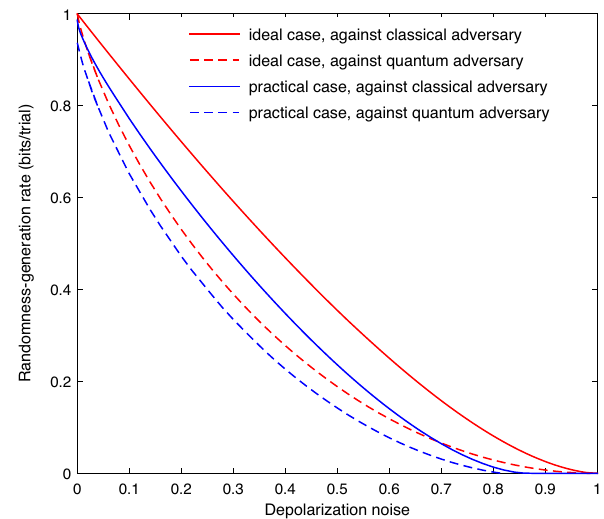
Fig. 1 Asymptotic randomness-generation rates R c and R q as functions of the depolarization noise d . For illustration purpose, here we simulate the result at a trial according to either the X -basis or Z -basis measurement on the depolarized single-photon state ð 1 (cid:2) d = 2 Þ 0 j i 0 h j þ d = 2 1 j i 1 h j , where 0 j i and 1 j i are the two eigenstates (in the single-photon subspace) of the Z - basis measurement and d quanti fi es the depolarization noise. At each trial the X -basis measurement is selected with probability P X = 0.9999, and so the imbalance τ = ( P X − P Z )/2 is exactly known. Our method can certify randomness without assuming that the state and measurements are fully characterized. Instead, our method requires only an upper bound δ on the misalignment angle between the two measurement bases and a lower bound q 1,lb on the probability of a single photon in a practical photon source. For the ideal case (the red curves), we set q 1,lb = 1 and δ = 0, while for the practical case (the blue curves), we set q 1,lb = 0.95 and δ = 5 ∘